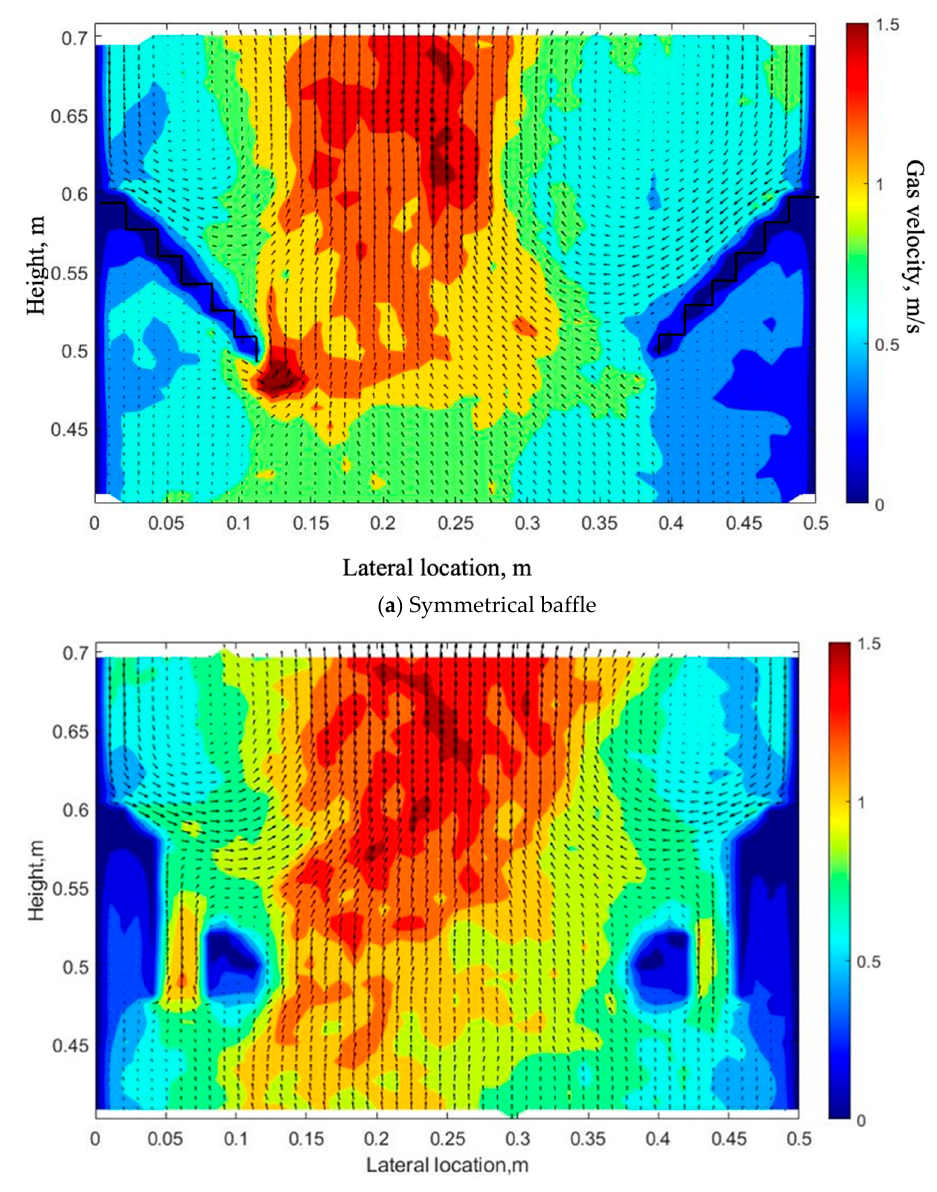
Figure 10. Gas holdup contours in the entire fluidized bed reactor using the symmetrical baffle with and without and the regular fluxtube under the superficial gas velocity of 0.4 m/s for even gas inlet configuration .